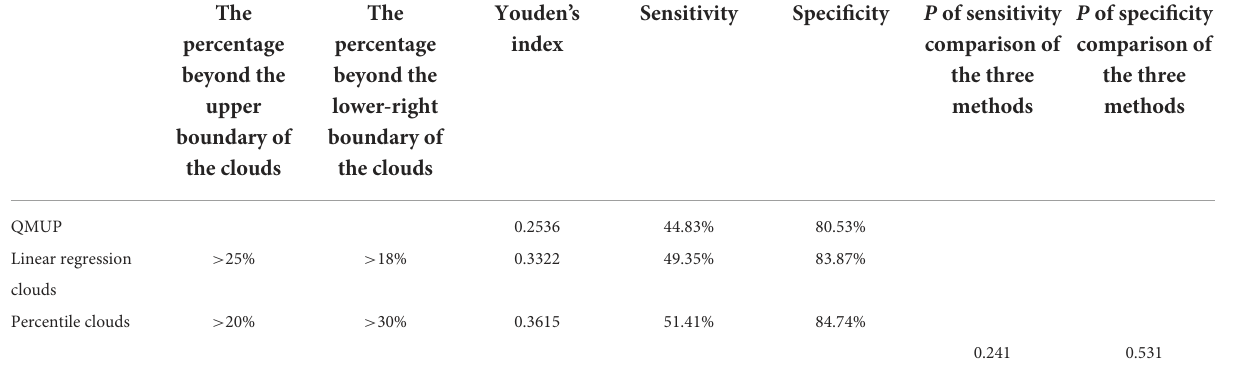
TABLE 11 The sensitivity and specificity of each method for discrimination of abnormal vs. normal muscles.